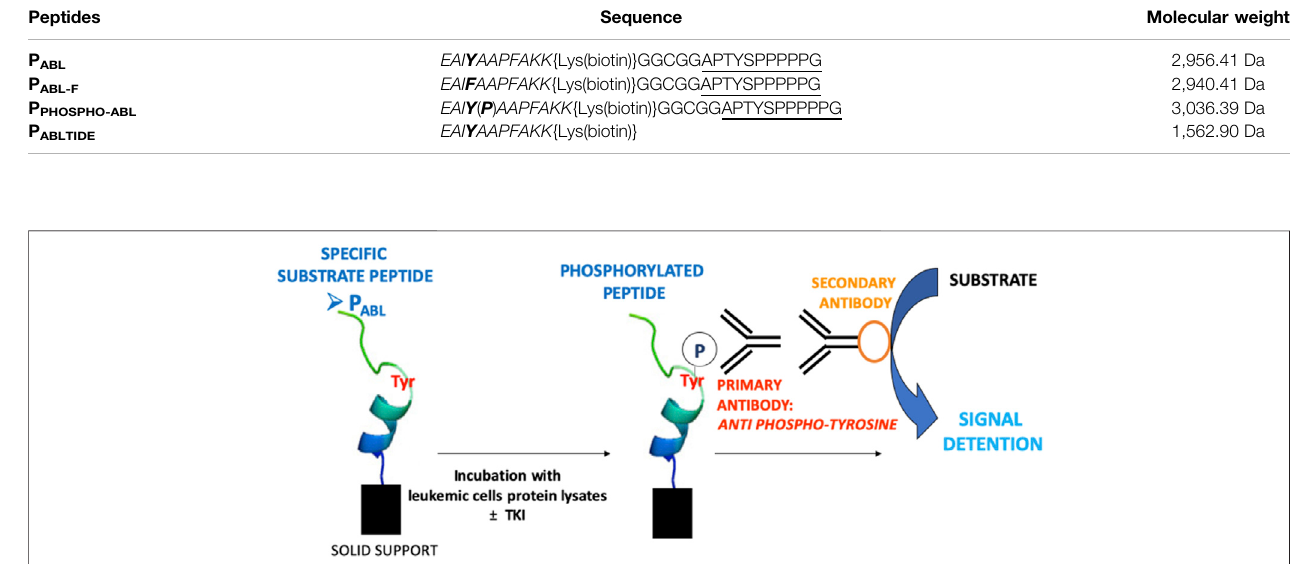
FIGURE 1 | Schematic illustration of P ABL -based ELISA assay principle.